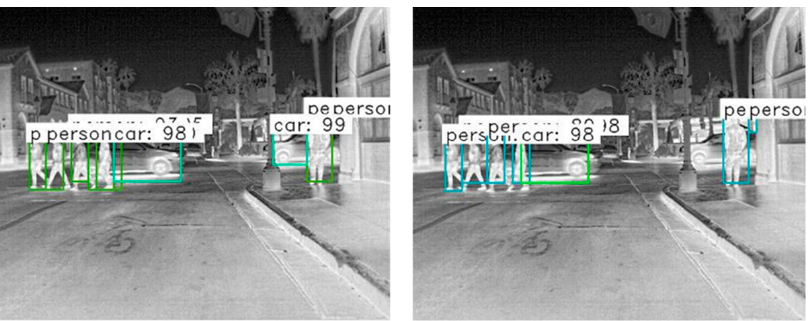
Figure 12. Comparison of target detection results between CMF-3DLSTM and CMF Net.